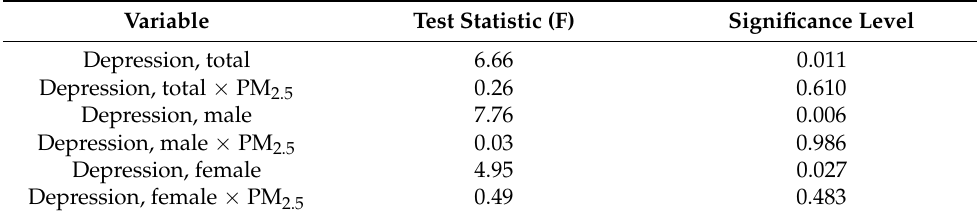
Table 5. Repeated measures analyses of covariance of the relationship between PM 2.5 and longitudinal changes in the incidence of